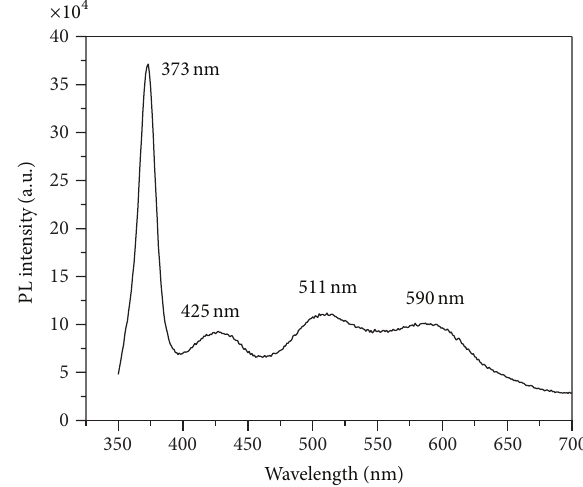
Figure 3: Room temperature PL spectra of the ZnO nanorod